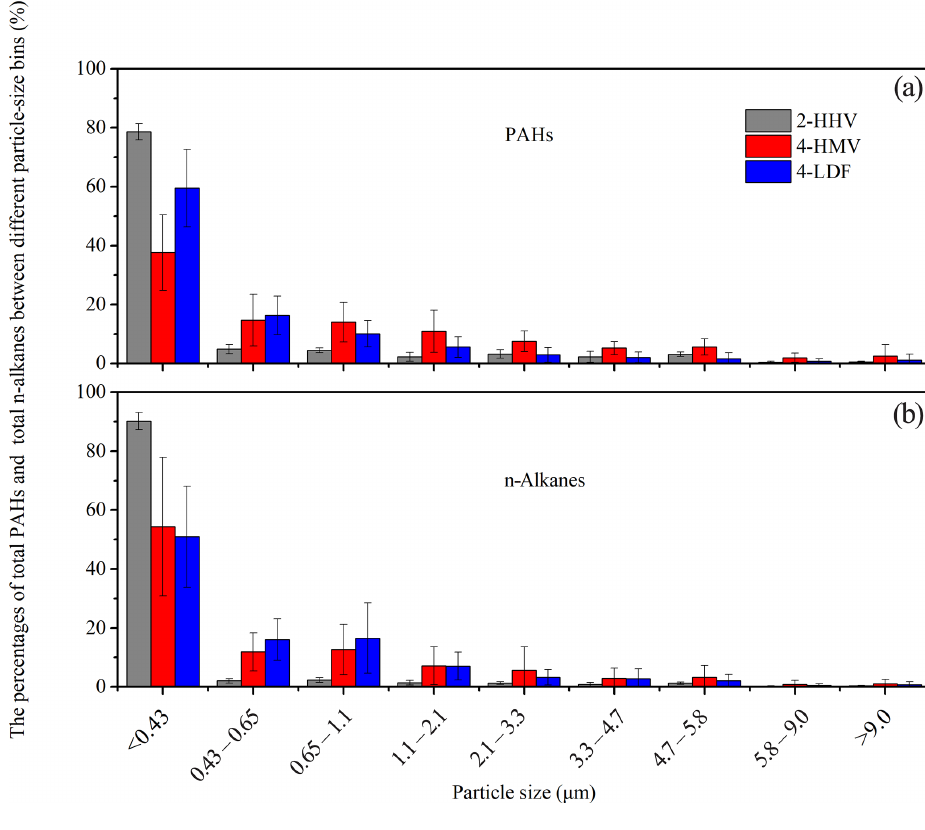
Figure 6. The distribution of total PAHs and total n -alkanes between different particle-size bins